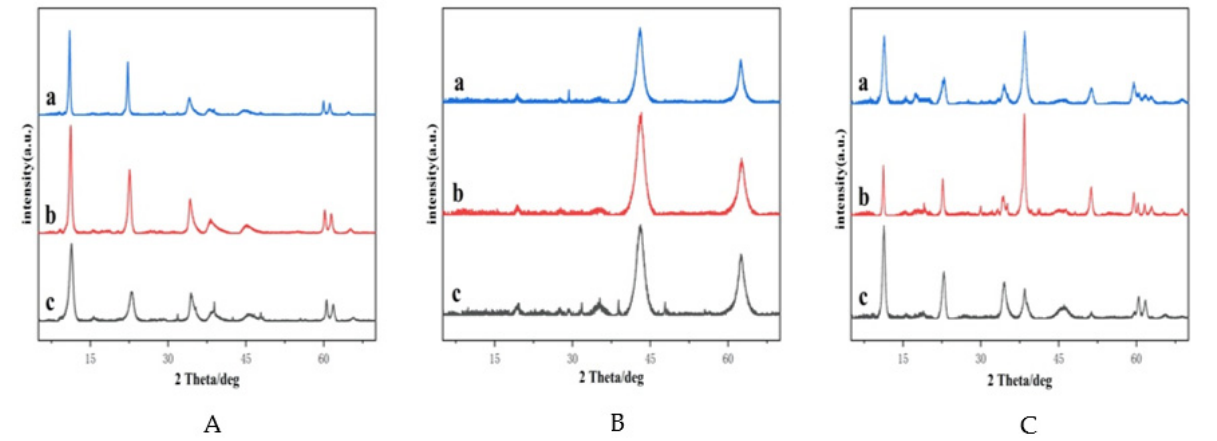
Figure 1. XRD patterns of Mg x Al–layered double hydroxides (LDHs) ( A ), Mg x Al–composite metal oxides (MMOs) ( B ), and re-Mg x Al–LDHs ( C ), where a, b, and c represent samples with Mg/Al ratios of 2:1, 3:1, and 4:1, respectively.